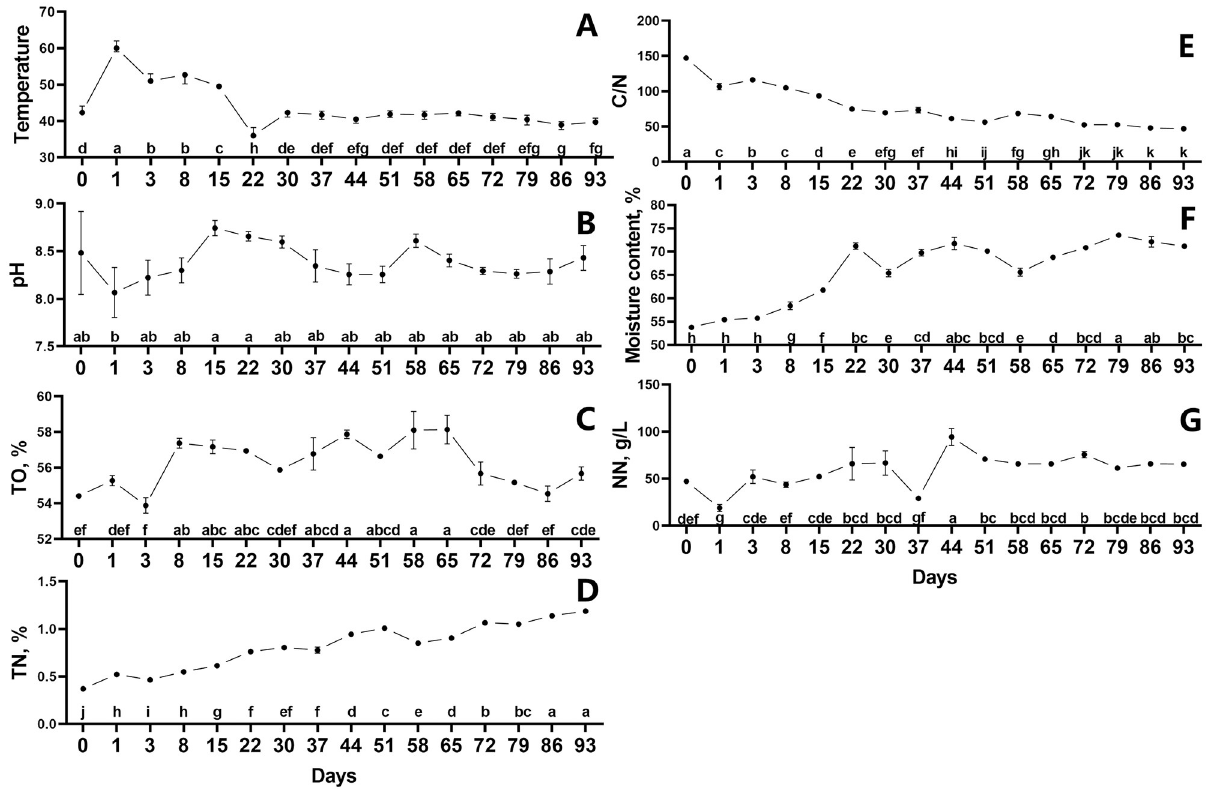
Fig 2. Changes of physiochemical parameters in ectopic fermentation bed. Temperature (A), pH (B), TO (C), TN (D), C/N (E), moisture content (F) and NN (G) were assessed during the EFS process. Statistical assessment was carried out with one-way ANOVA followed by post hoc test using Dunn’s multiple comparison test. Values with different letters are significantly different at P <